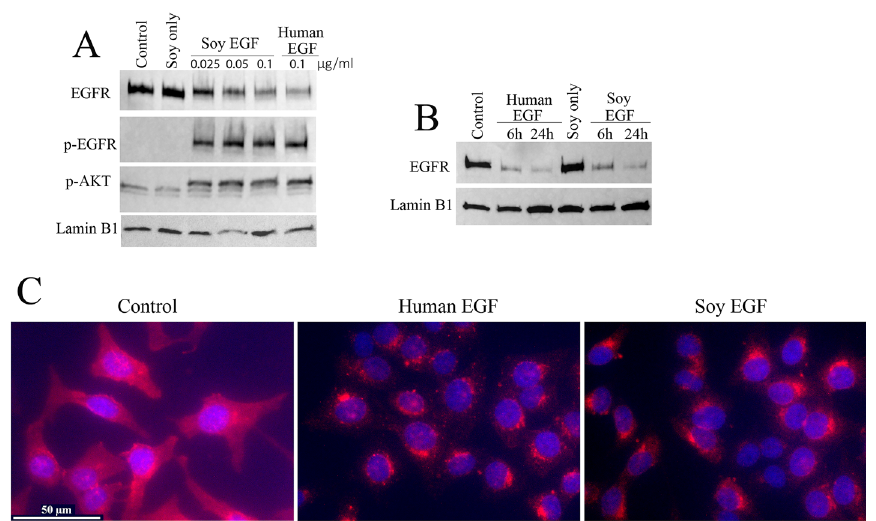
Fig 5. Soybean produced EGF displayed comparable bioactivity to commercially available EGF. Panel A. Soybean produced hEGF induces a rapid phosphorylation of Hela cell EGFR. Serum free media (SF) and SF media with soymilk alone does not induce EGFR phosphorylation and degradation. Soymilk from seeds producing ShEGF added at different concentrations (0.1, 0.05, 0.025 μ g/ml) induced concentration- dependent EGFR degradation comparable to the effect of rhEGF. Serum free media and serum free media with nontransgenic soybean soymilk (negative controls) showed no effect on inducing pEGFR. In contrast soymilk from ShEGF soybeans given at different concentrations (0.1, 0.05, 0.025 μ g/ml) induced pEGFR comparable to control rhEGF. pAKT indicates the functional activation of EGFR. Lamin B1 was used as a loading control. Panel B. Exogenous commercial rhEGF and ShEGF induces an internalization and degradation of EGFR in Hela cells shown as a decrease in abundance assayed by immunoblot. The results shown demonstrate that soymilk alone has no intrinsic bioactivity with respect to EGFR abundance. The rhEGF is not degraded in soymilk over 24 hours having the same bioactivity as control recombinant rhEGF. — Ctrl- SF media alone. Soy EGF and rhEGF are at 0.1 μ g/ml. Lamin B1 was used as a loading control. Panel C. Shown is an immunohistochemical assay of Hela cells showing that ShEGF induces internalization of the EGFR comparable to that from control rhEGF. In C, the cells were first treated with soy/EGF or human EGF for 6 hours, fixed and then immunostained with EGFR antibody overnight. EGFR shows red staining while nucleus was stained by DAPI and shows blue staining.